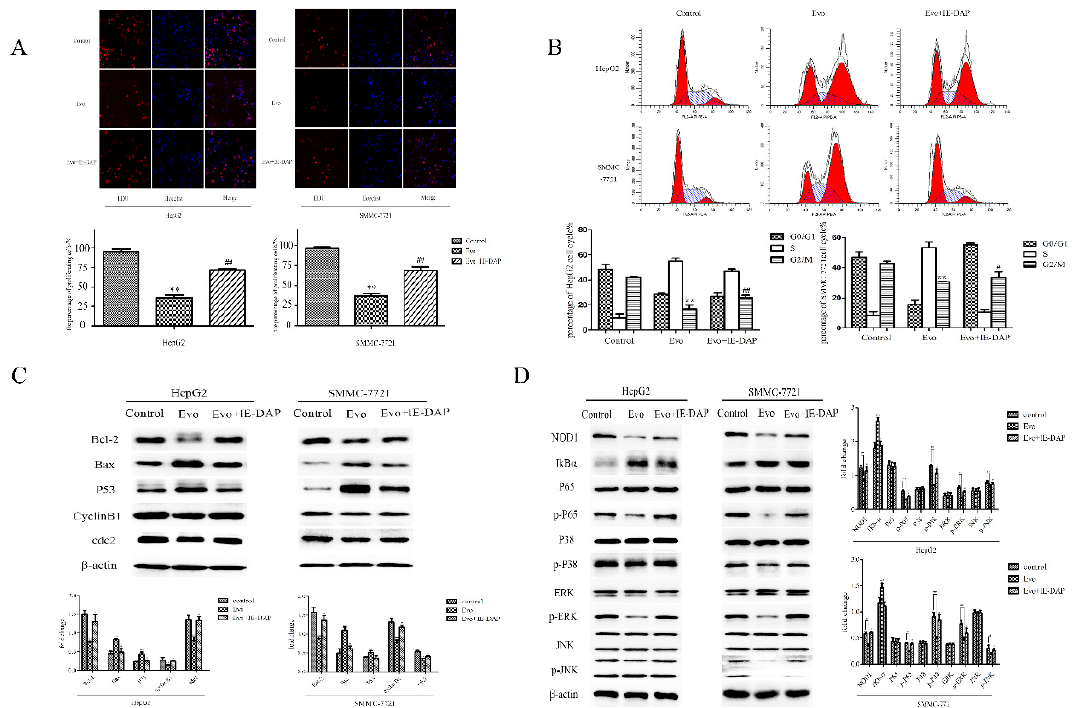
Figure 3. Evo induces apoptotic cell death of HepG2 and SMMC-7721 cells via the NOD1-mediated apoptotic pathway in vitro. HepG2 and SMMC-7721 cells were treated with 10 µg/mL IE-DAP for 2 h before exposure to 1 µM Evo. Apoptosis ( A ), cycle arrest ( B ), apoptosis-related protein levels ( C ) and the proteins’ levels of NOD1 pathway ( D ) in treated and untreated cells were measured by 5-ethynyl-2 ′ -deoxyuridine ( EdU) (×40), cellular propidium iodide (PI) fluorescence and Western blot methods. The percentage of proliferating cells (EdU+) was quantitated using ImageJ software (National Institutes of Health, Bethesda, MD, USA). Values are means and standard errors of three separate experiments (* p < 0.05 and ** p < 0.01 versus control, # p < 0.05 and ## p < 0.01 versus Evo).